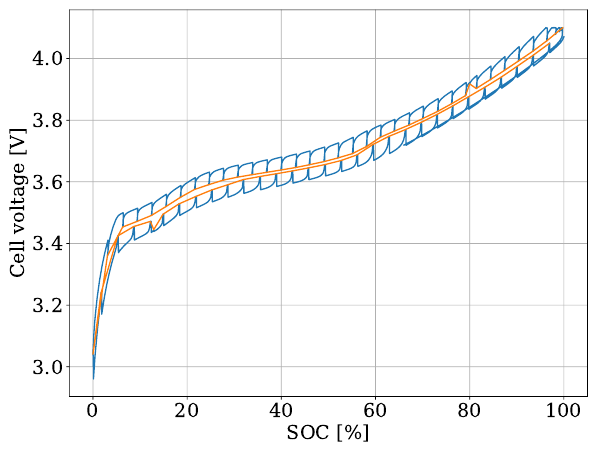
Figure 5. GITT test carried out at 28 Ah NMC LIB cell at